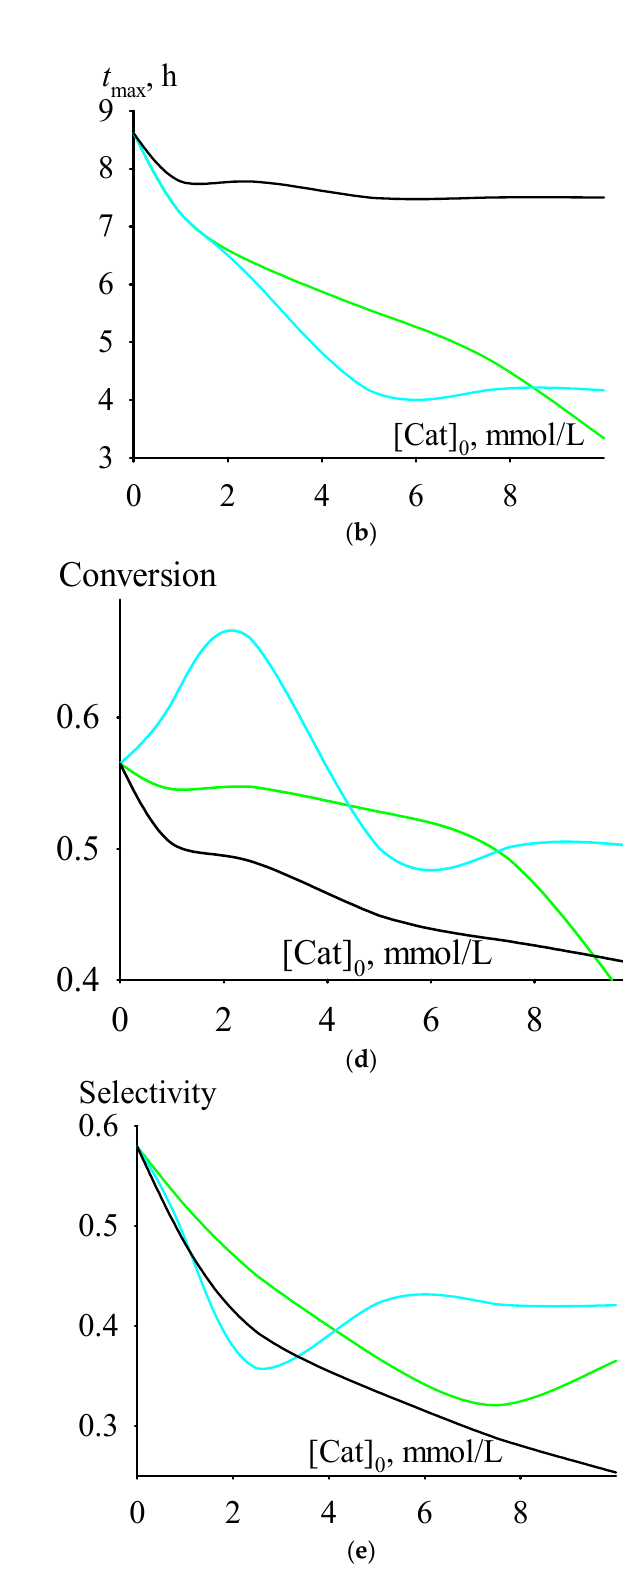
Figure 6. The dependencies of criterion C ( a ), t max ( b ), [ROOH] max ( c ), cumene conversion at t max ( d ), and selectivity at t max ( e ) versus initial catalyst concentration.